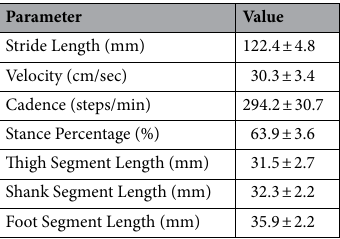
Table 1. Spatiotemporal parameters and morphometric measurements.